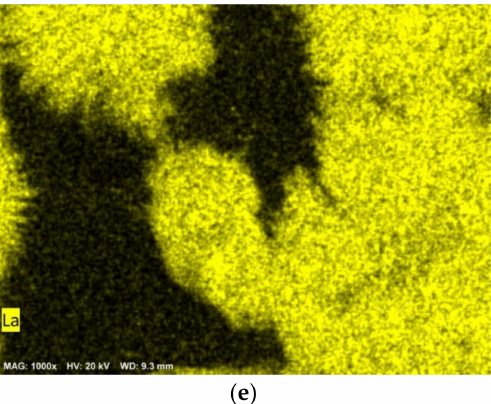
Figure 11. Approach to the surface of 1018 carbon steel evaluated with the addition of 1.0 mM of LaCl 3 . ( a ) secondary electron image; ( b ) Fe mapping; ( c ) O mapping; ( d ) C mapping; ( e ) La